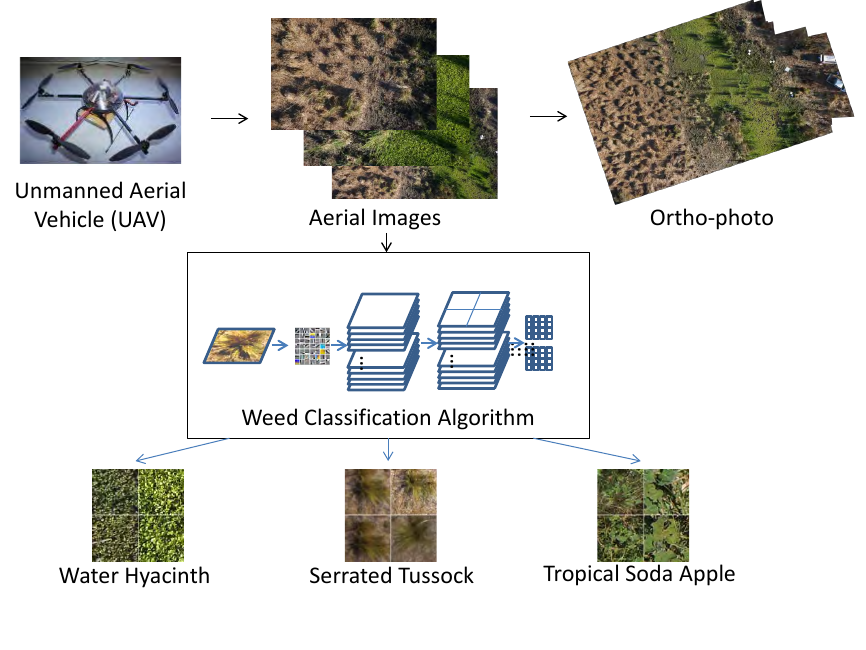
Figure 1. Overview of our methodology. A multi-rotor UAV was used to collect aerial images. The images were mosaicked and registered into an ortho-photo. Further, a weed classifier has been developed to classify patches of water hyacinth, serrated tussock and tropical soda apple.